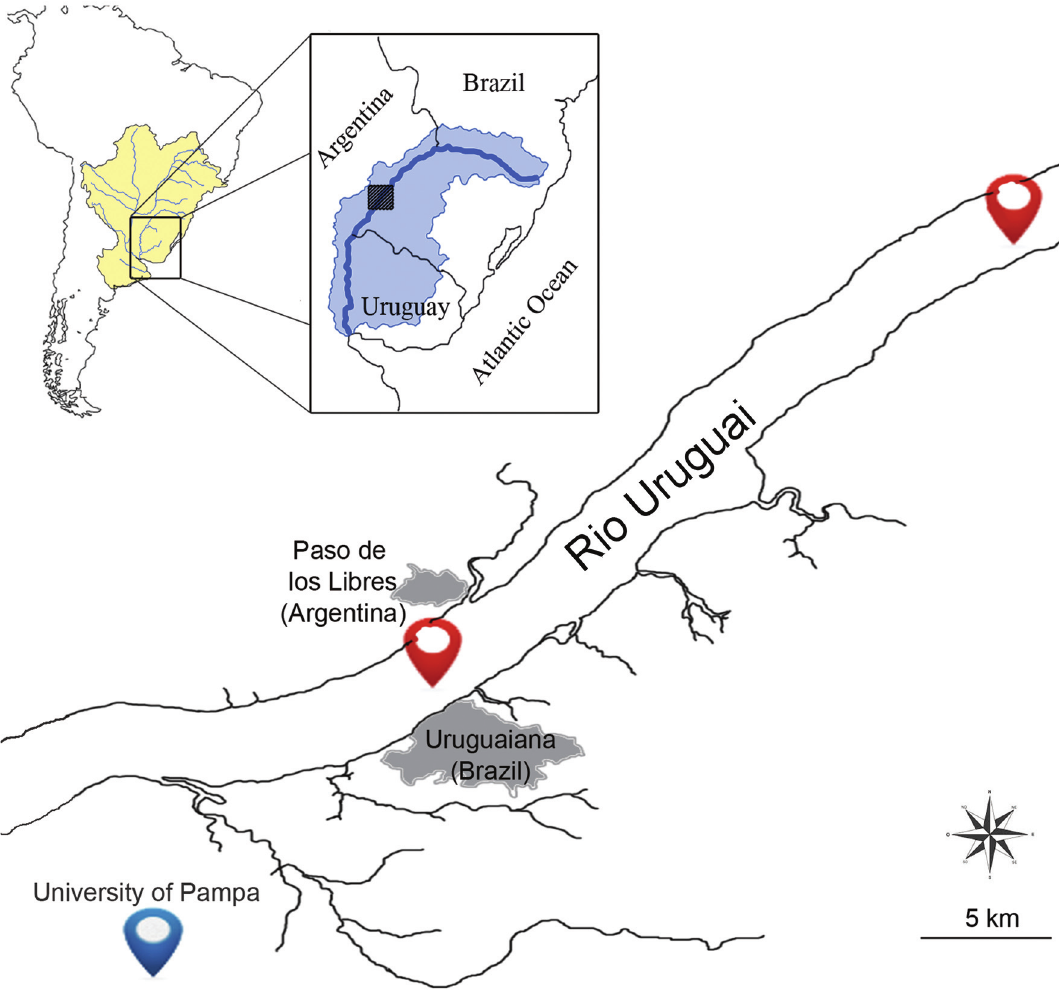
Fig. 1. Map of sampling sites. Red points indicate the sites of sampling in lotic environment, and blue point indicates the dam (lentic environment). The La Plata basin in the South America is highlighted in yellow and the Uruguai basin in blue. Urban areas of Paso de los Libres and Uruguaiana cities are indicated by a gray